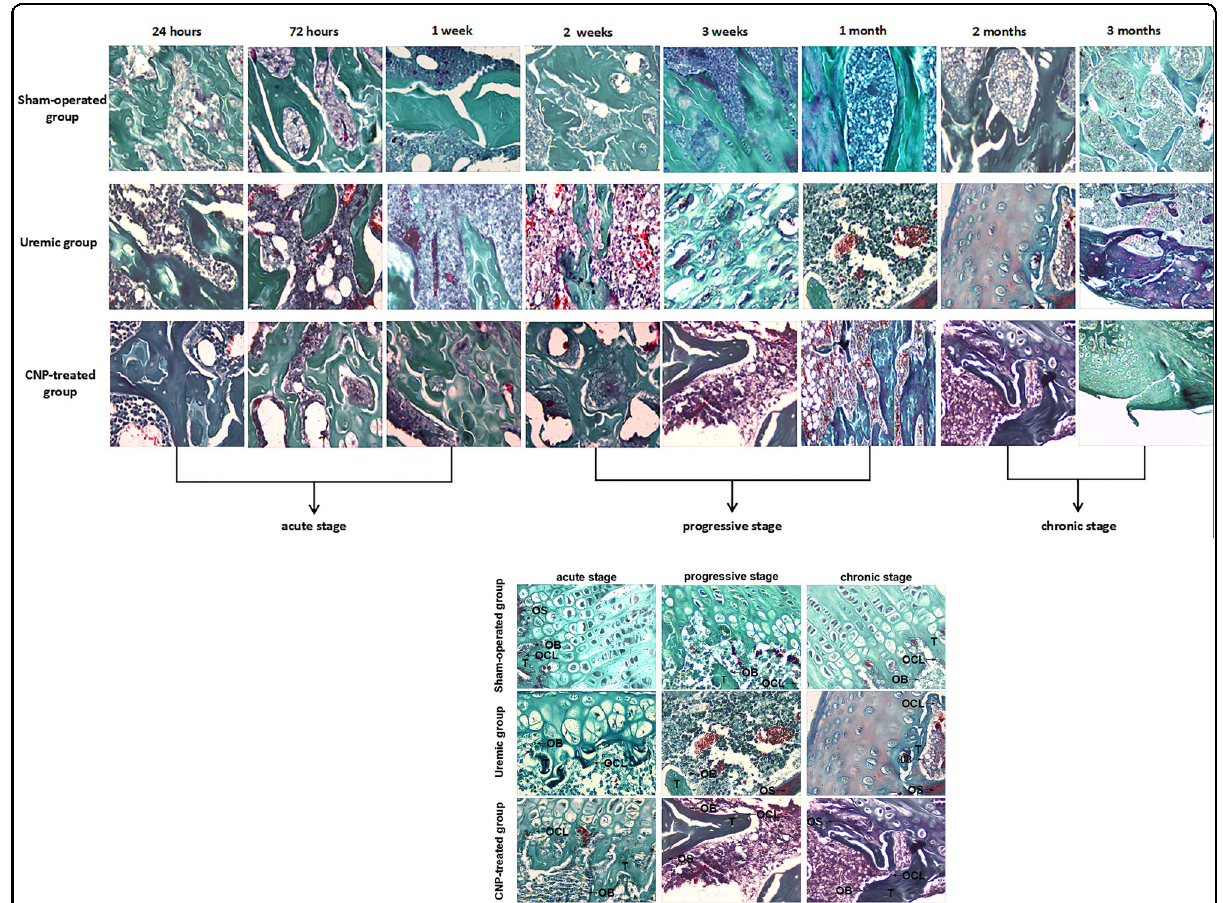
Fig. 5 Goldner ’ s trichrome staining of distal femurs in sham-operated, uremic, and CNP-treated rats. Uremic group vs. sham-operated group: In the acute stage, there was no dramatic difference in bone histology between the uremic group and sham-operated group. Pathological lesions in the uremic group formed in the progressive stage and gradually deteriorated thereafter. Adriamycin injection triggered a low-turnover bone lesion characterized by an evident decrease in osteoblasts (OB), osteoclasts (OCL), and trabecular (T) volume thickness, and a clear elevation in osteoid (OS) volume, compared with the sham-operated group. CNP-treated group vs. uremic group: In the acute stage, bone histology of the CNP-treated group was identical to that of the uremic group. Subsequently, CNP injection contributed to prominent elevations in osteoblasts (OB), osteoclasts (OCL), osteoid (OS) volume, and trabecular (T) thickness in the uremic